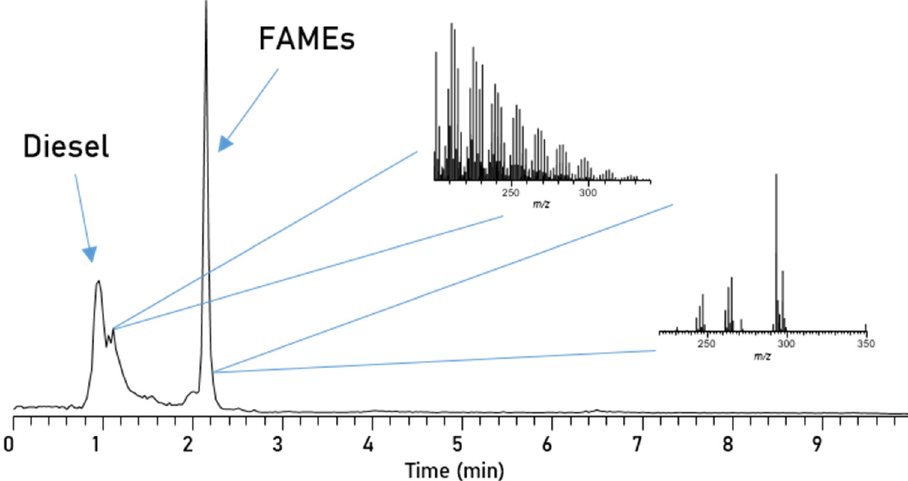
similar information compared to Method 1, but loses the chromatographic information about the esters. Figure 9. Chromatogram of blend, separated via the amino functionalized NP-HPLC with Method 2.